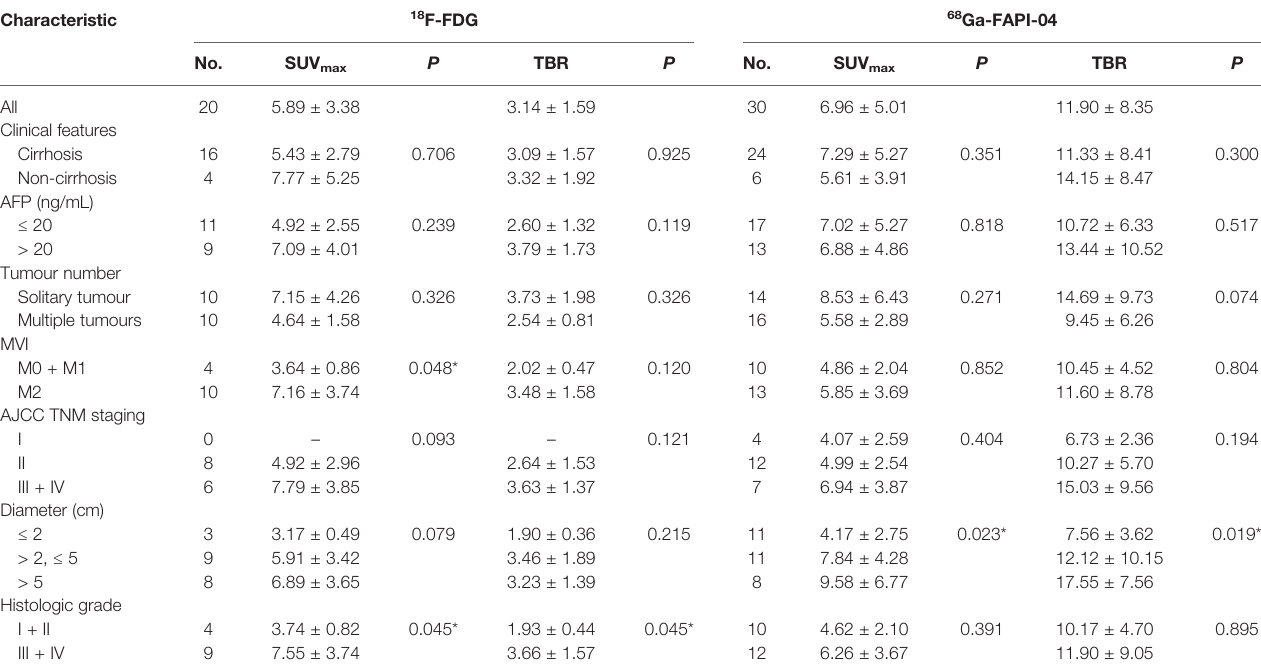
TABLE 4 | Uptake intensities of 18 F-FDG and 68 Ga-FAPI-04 in positive lesions.